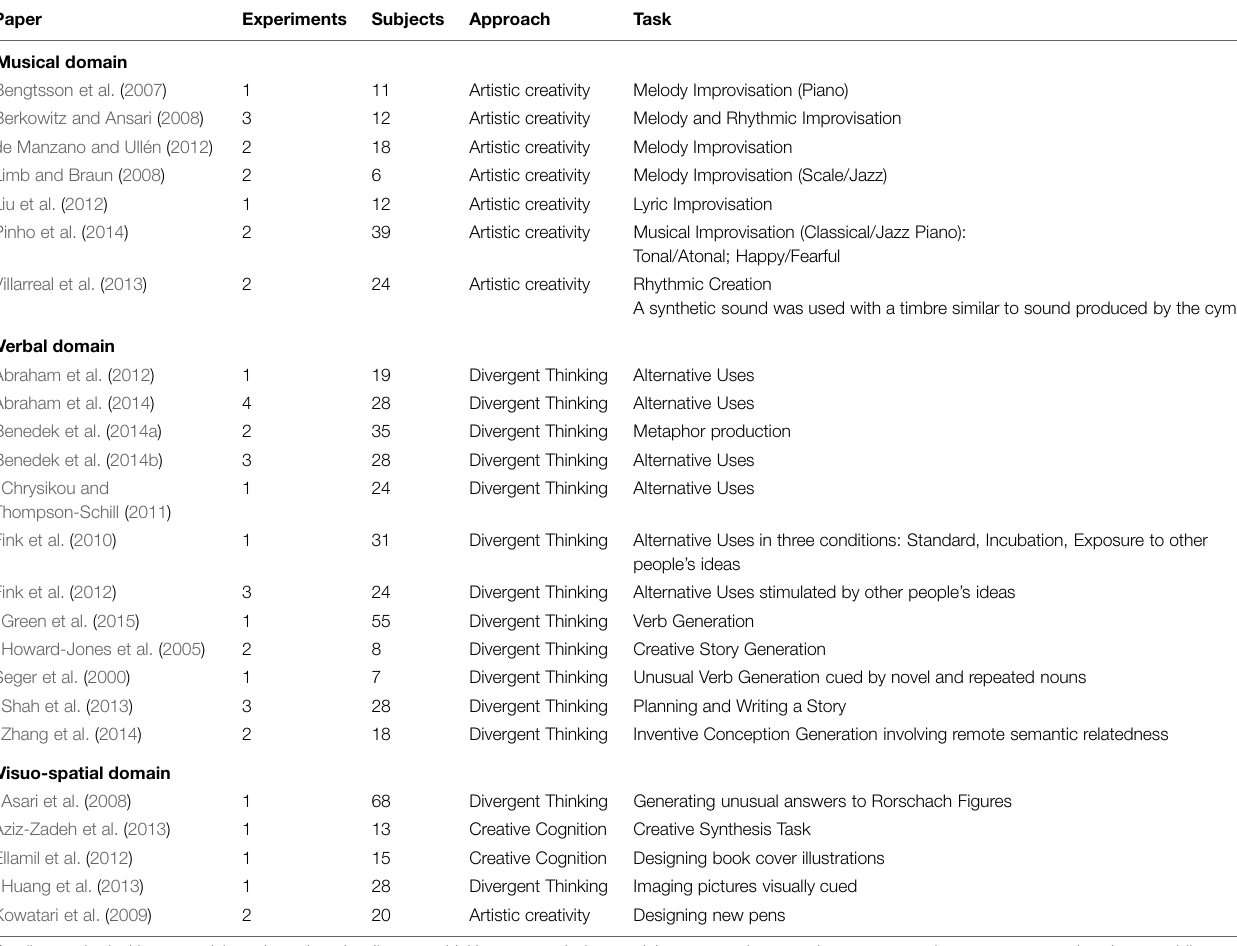
TABLE 1 | List of papers included in the meta-analysis for each